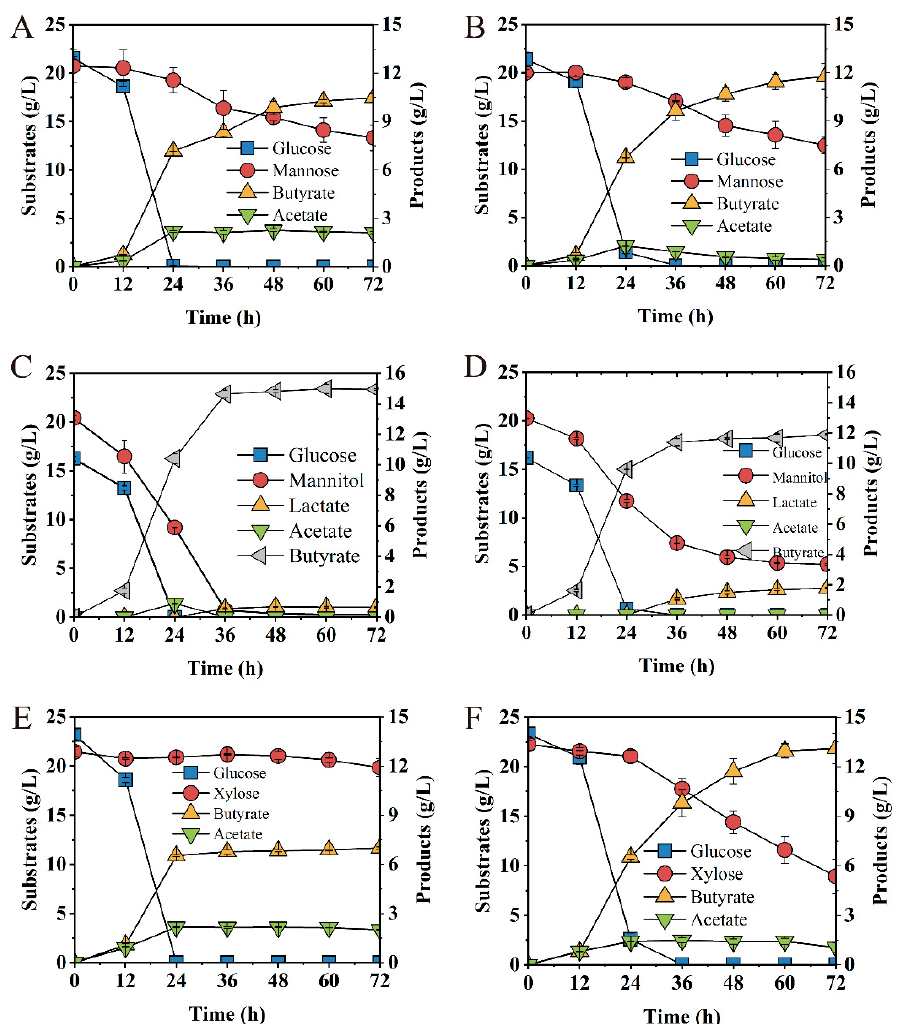
Figure 7. Fermentation kinetics of Ct ( left row) and Ct/ ∆ abrB ( right row) with glucose/mannose mixture (1:1) ( A , B ), glucose/mannose mixture (1:1) ( C , D ), and glucose/mannitol mixture (1:1) ( E , F ) in CGM supplement with CaCO 3